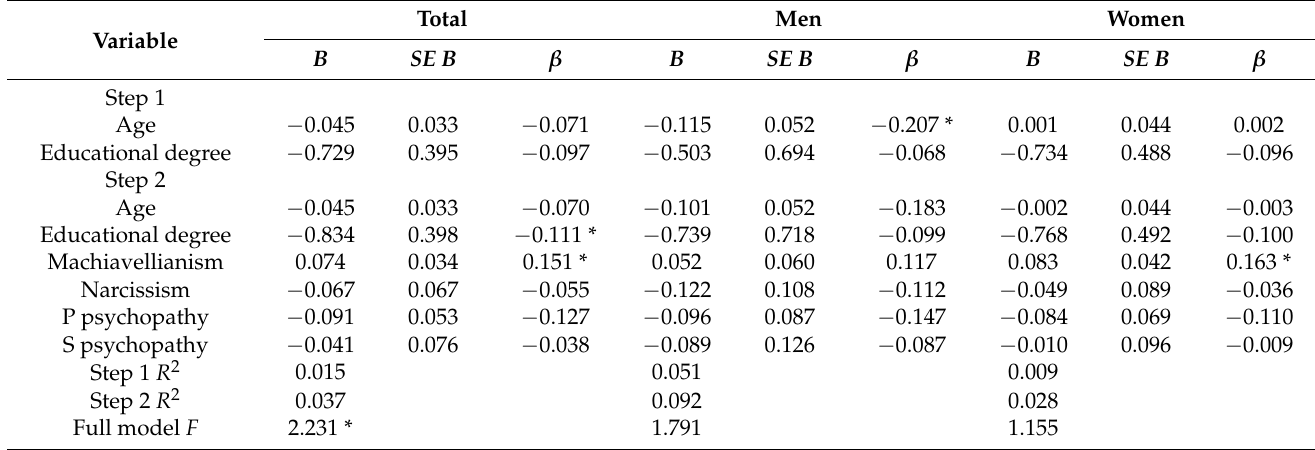
Table 3. Multiple regression of Dark Triad traits on restrained eating by sex.